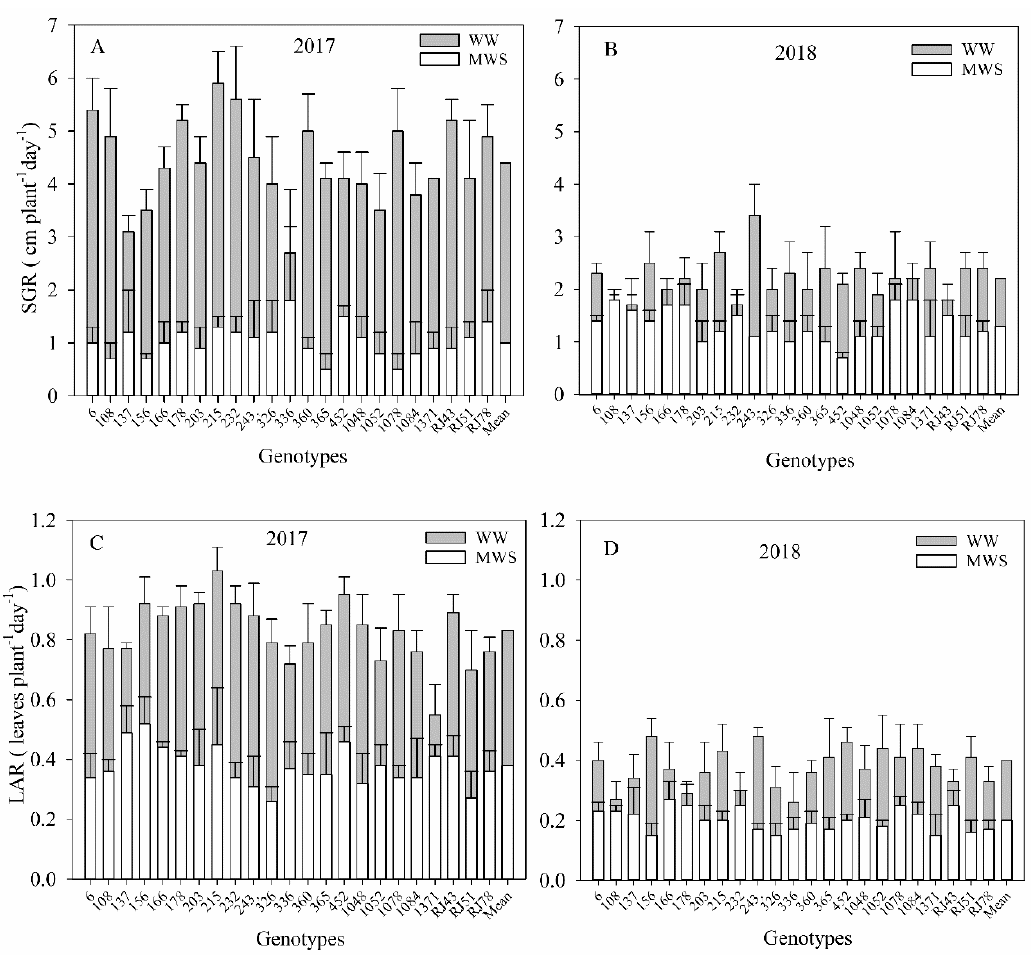
Figure 2. Stem growth rate (SGW) and leaf appearance rate (LAR) of each genotype measured in 2017 ( A , C ) and 2018 ( B , D ) in well-watered (WW) (grey bars) and moderate water stressed (MWS) (white bars) (White bars). Values are the mean ± SE (N = 5).